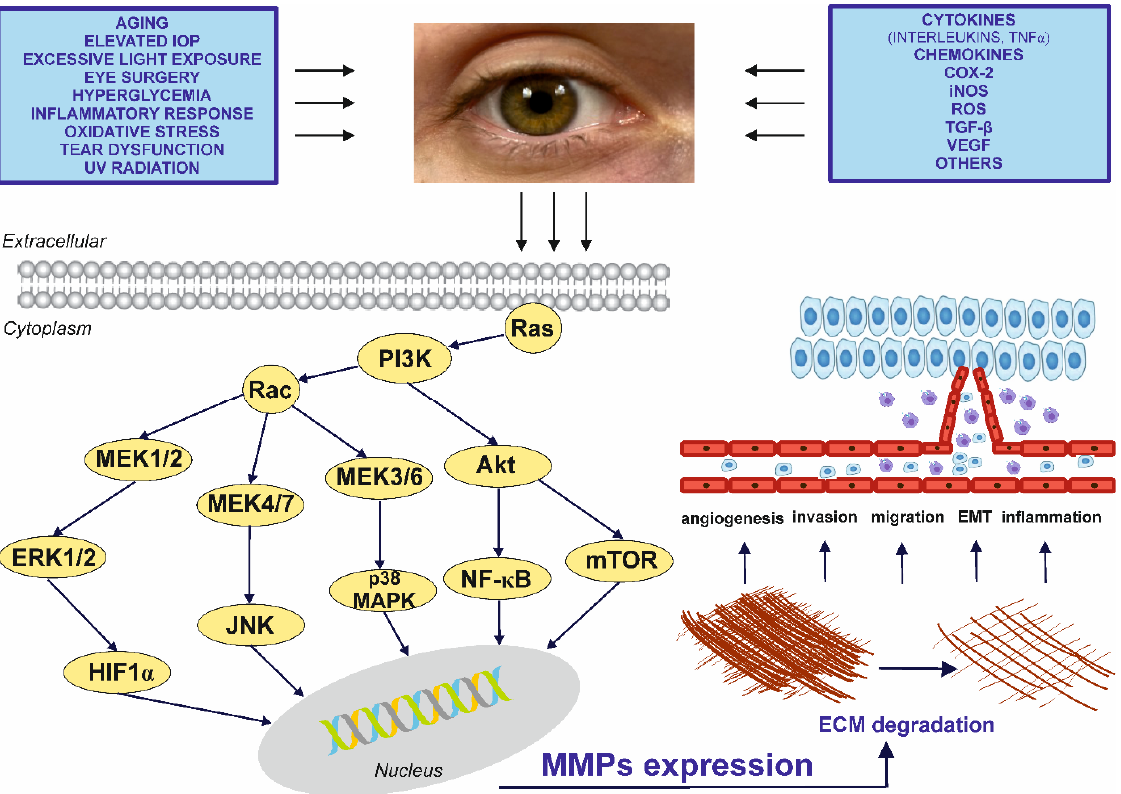
Figure 2. A schematic diagram showing molecular mechanisms involved in stimulation of the MMPs expression and effects being results of the MMPs action in the eye diseases. Akt—protein kinase B; COX ‐